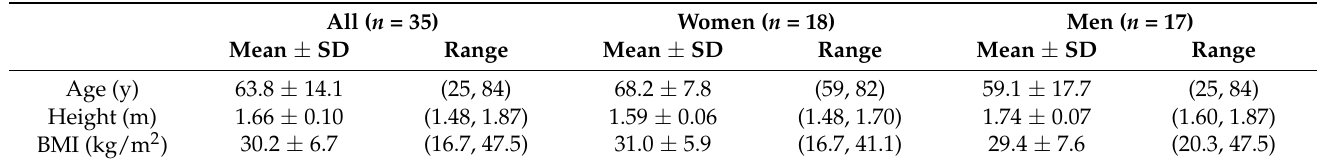
Table 1. Characteristics of the study